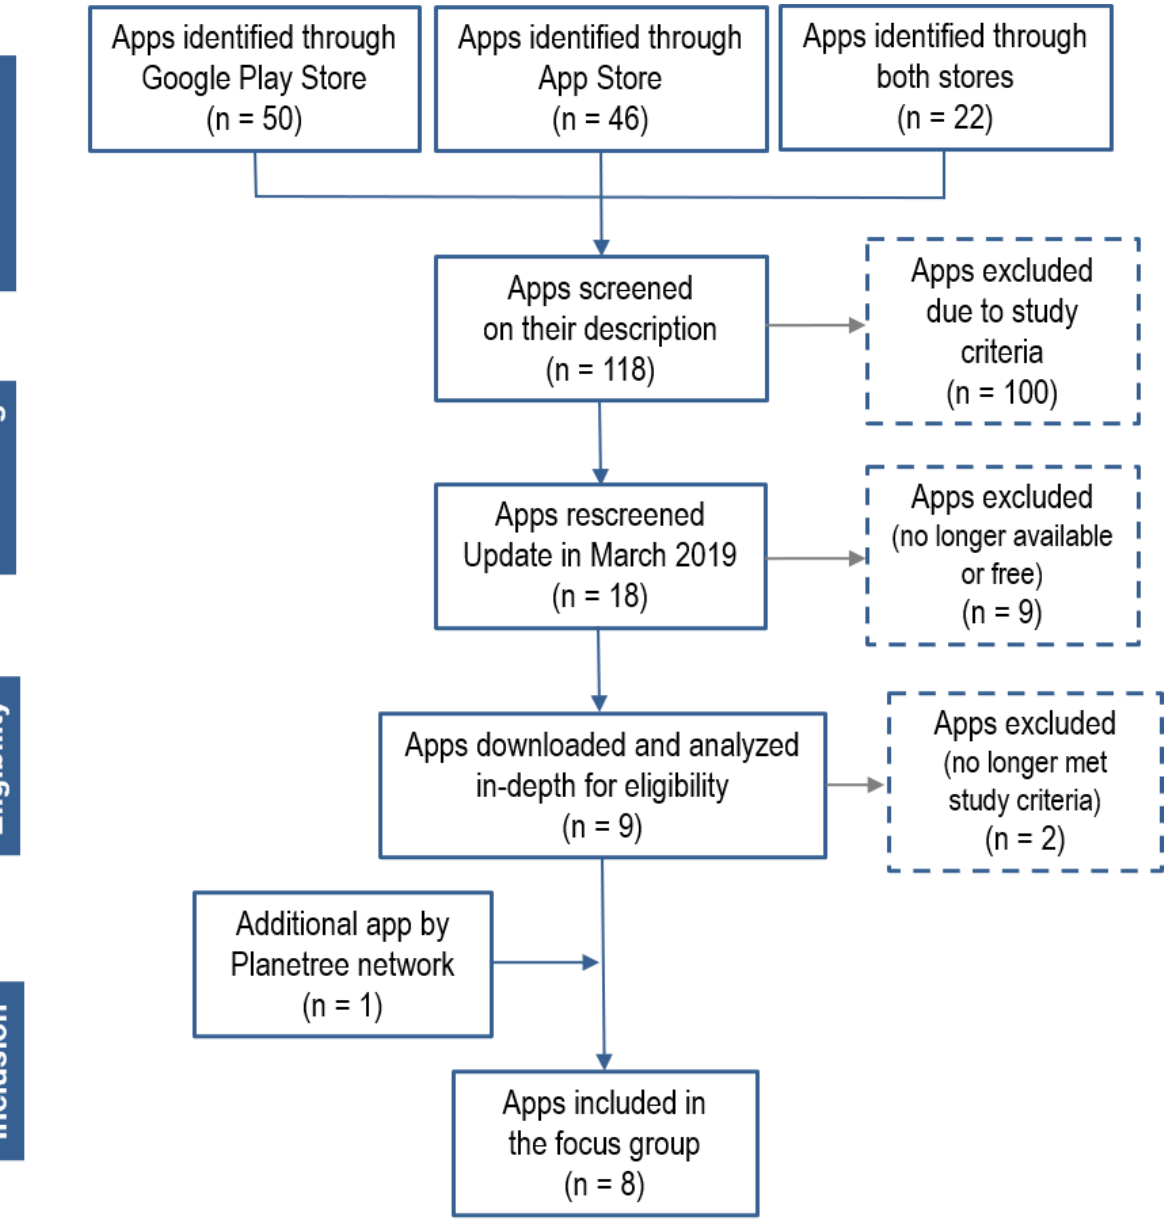
Figure 1. Flowchart of the app selection